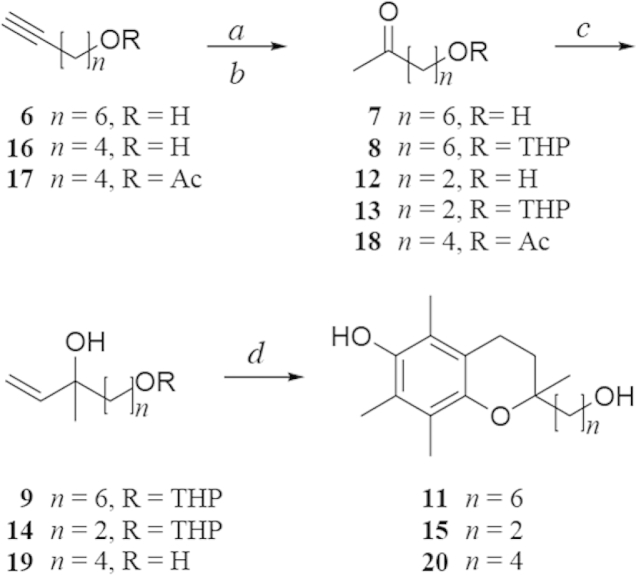
Synthesis of key hydroxychromans for MitoE2, MitoE4 and MitoE6. Reagents and conditions: a HgO, Tf2O, CH3CN (10 min), tetramethylurea (5 min), H2O, CH2Cl2; b DHP, PPTS, CH2Cl2; c vinylMgCl, THF; d HCOOH, 10, reflux.